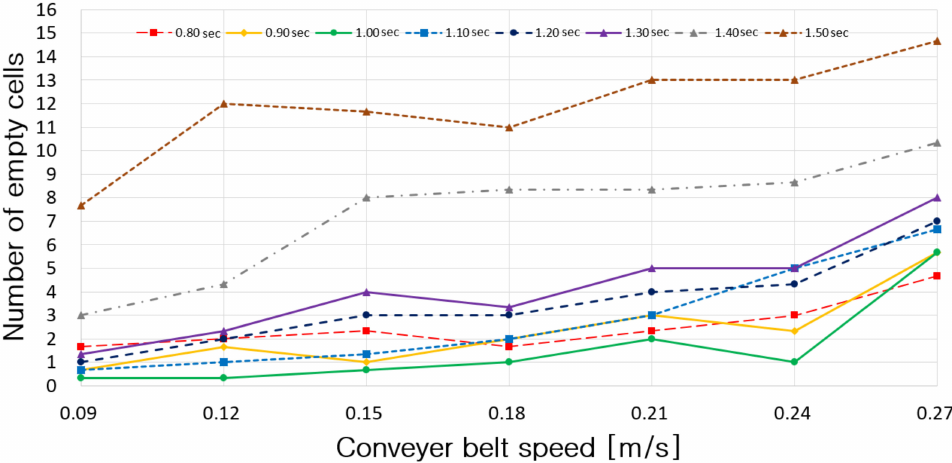
Figure 19. Number of empty cells according to conveyor belt